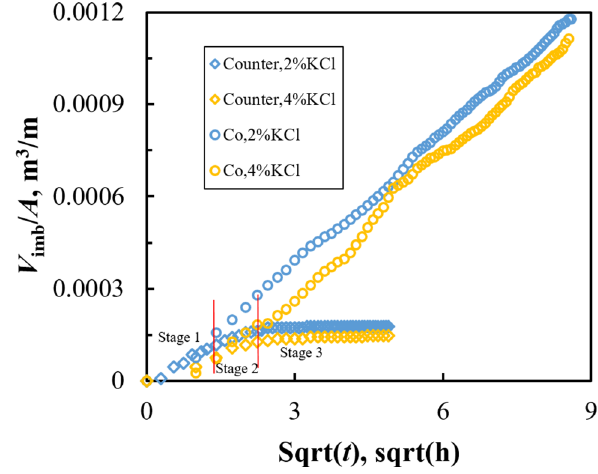
Fig. 3 Imbibed volume per unit imbibed area ( V time with different KCl concentrations